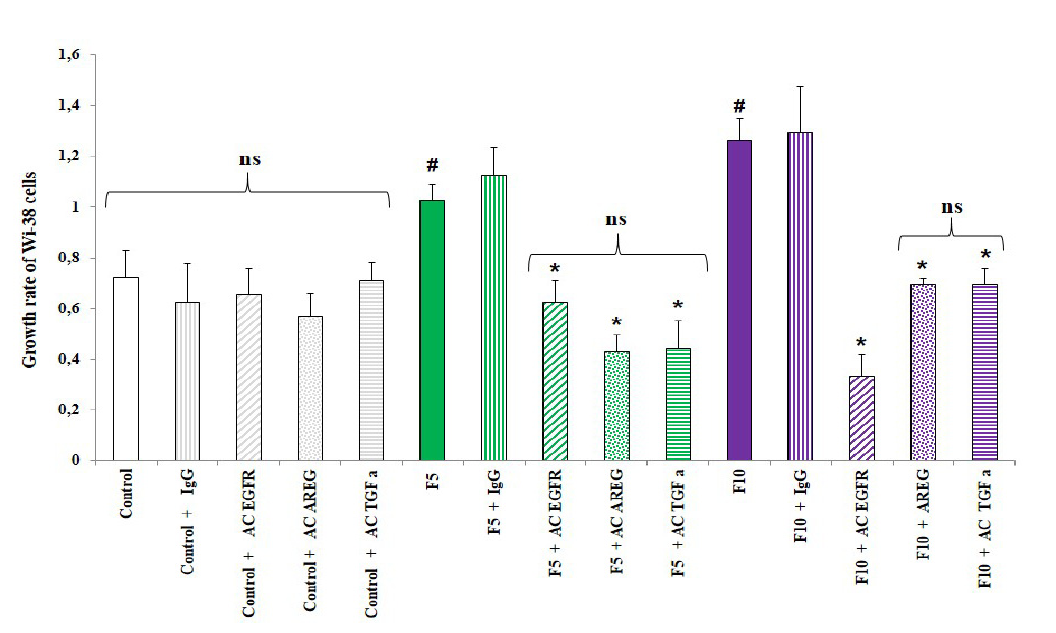
Figure 4. Involvement of anti-epidermal growth factor receptor (EGFR) ligands (amphiregulin and TGF α ) in fibroblast proliferation. Wi-38 cells were treated with conditioned media from control HBE cells or HBE cells treated with fine PM (5 μ g/cm², 10 µg/cm²) supplemented or not with anti-EGFR, anti-AREG, anti-TGF α or anti-mouse IgG. Wi-38 cell counting was performed 72 hours later. Cell proliferation of Wi-38 cells was expressed as growth rate. #: Different from control ( p < 0.05), *: Different from the condition without antibodies, n =